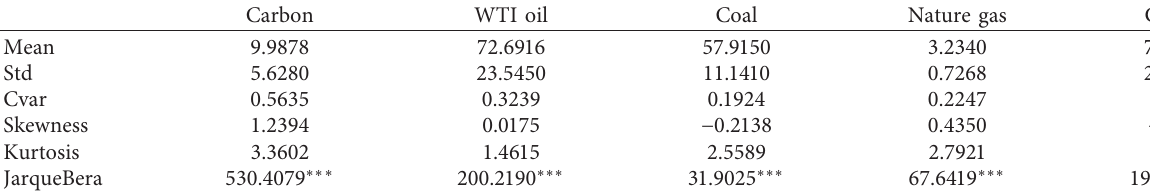
Table 1: The results of the descriptive statistics of the sample